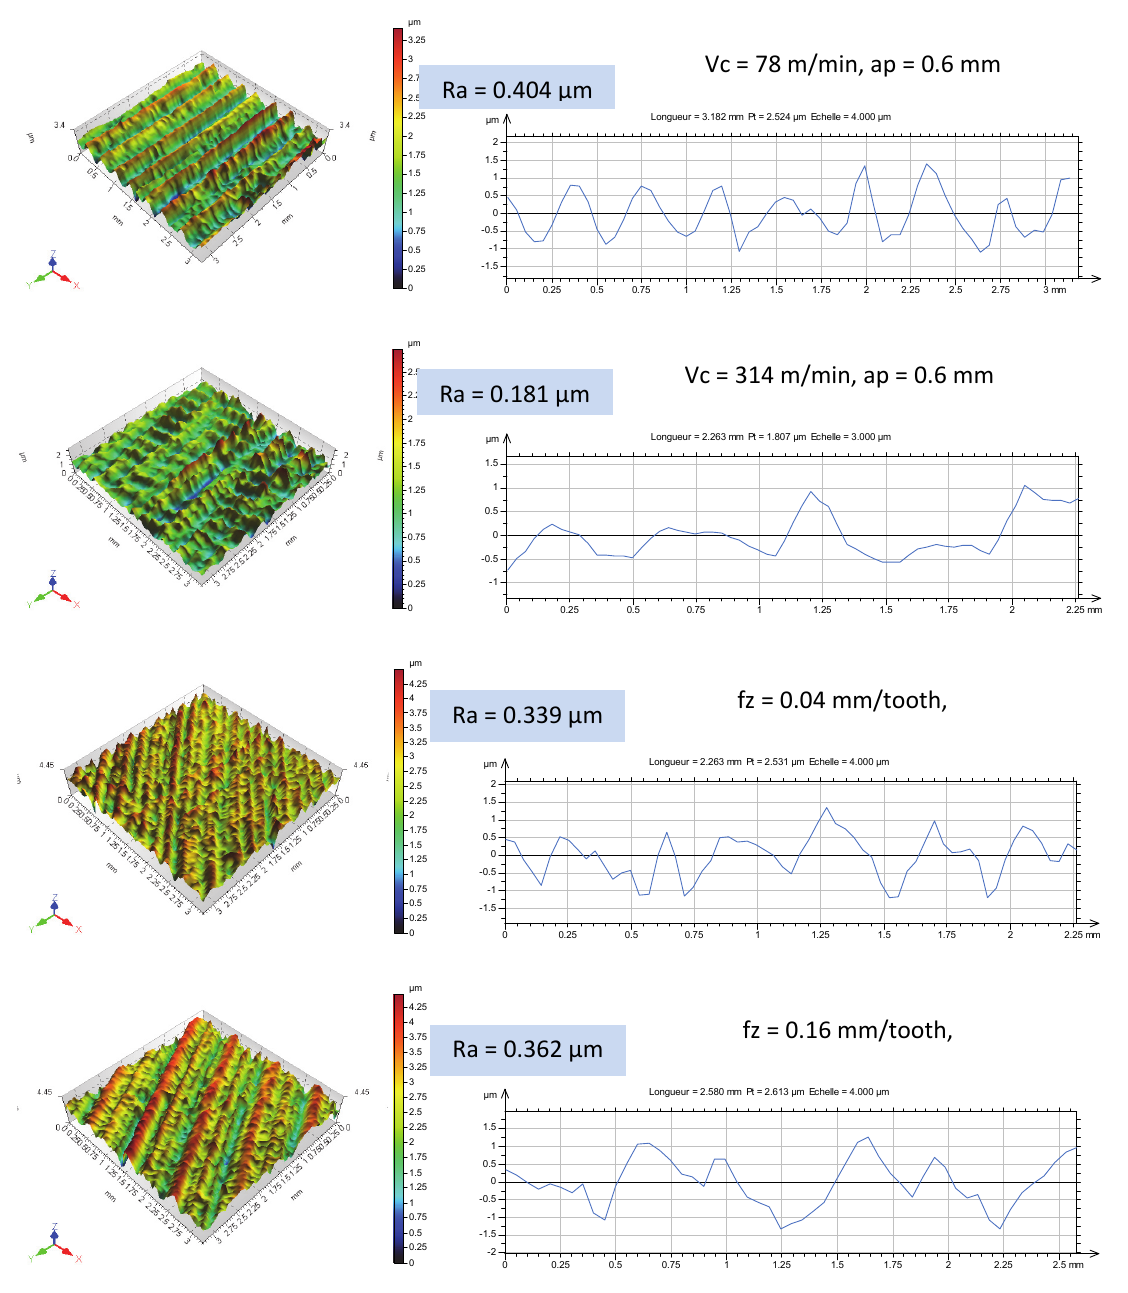
Fig. 17. 3D surface topography for